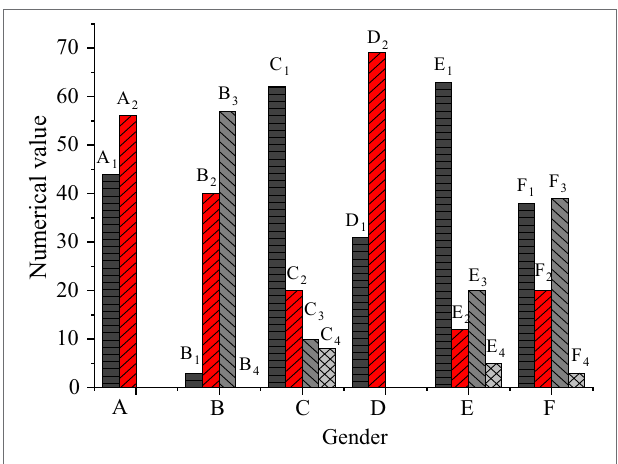
FIGURE 5 | Descriptive statistical results of subjects’ basic information (a: Gender, a1: Male, a2: Female, b: Education, b1: Junior college and below, b2: Bachelor, b3: Master, b4: Doctor, c: Length of service, c1: Less than one-year, c2: 1–5 years, c3: 5–10 years, c4: 10–20 years, d: Marital status, d1: Married, d2: Unmarried, e: Age, e1: 20–35 years, e2: 35–45 years, e3: 45–55 years, e4: over 55 years, f: Corporate nature, f1: Sino-foreign joint venture, f2: Foreign enterprises, f3: Chinese